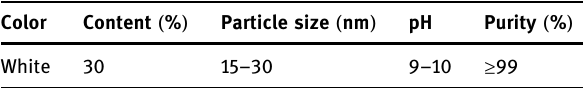
Table 4: Properties of